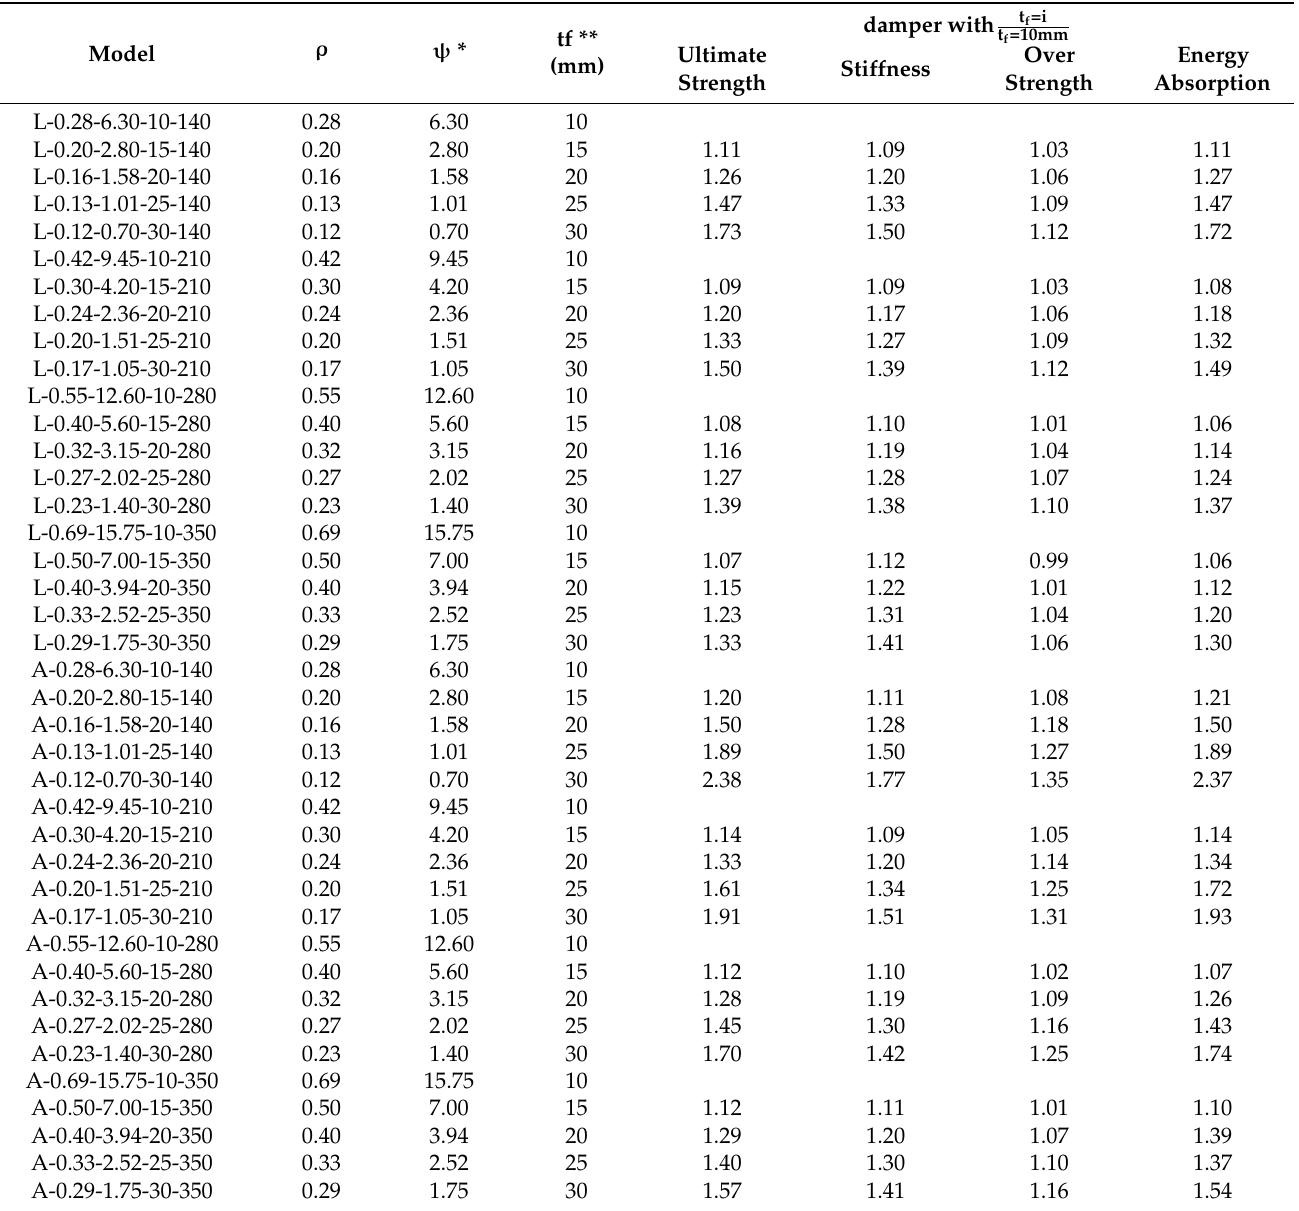
Table 6. Comparing the parameters damper with different t f with t f = 10